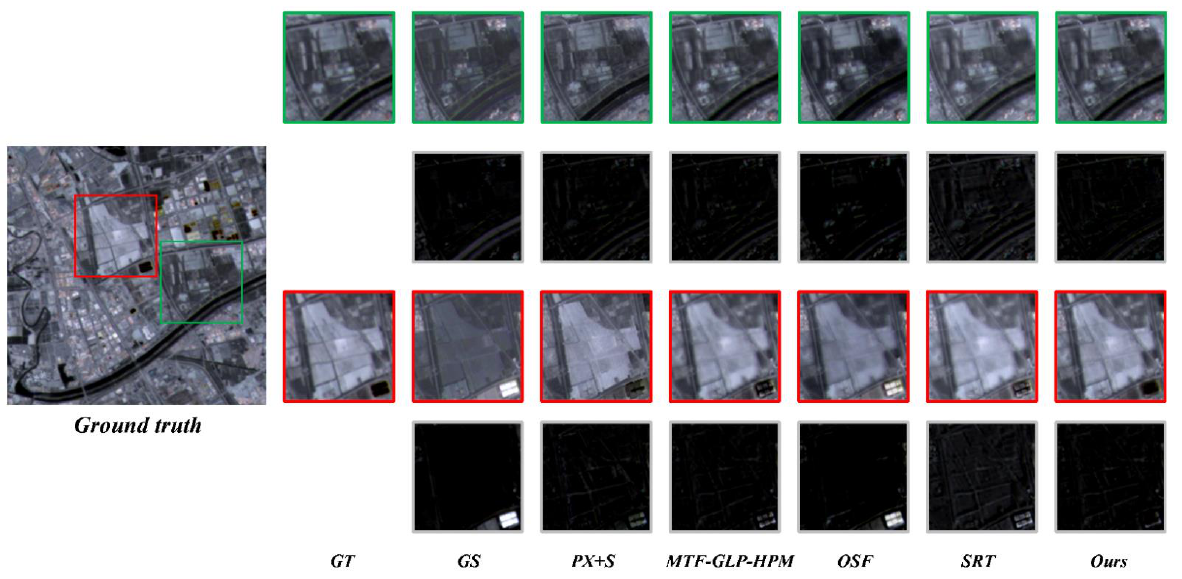
Figure 2. Comparison of fusion results of different algorithms on simulation data (the original image was taken in Shanghai on 8 April 2022; scene: port).